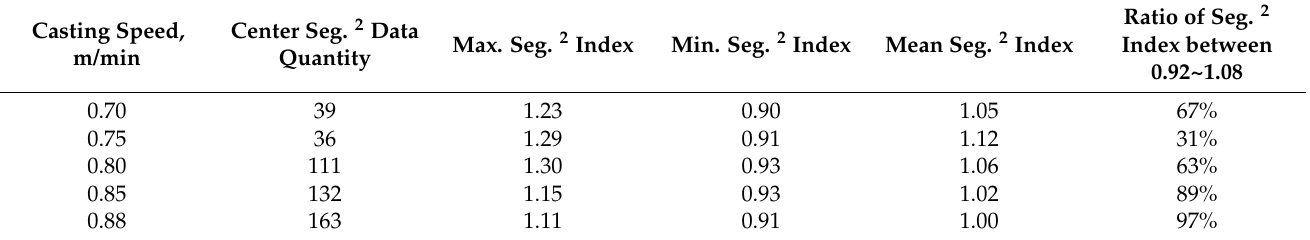
Figure 8. Hot etched bloom longitudinal sections of different casting speed trials. Table 3. Bloom center carbon segregation level at different casting conditions.